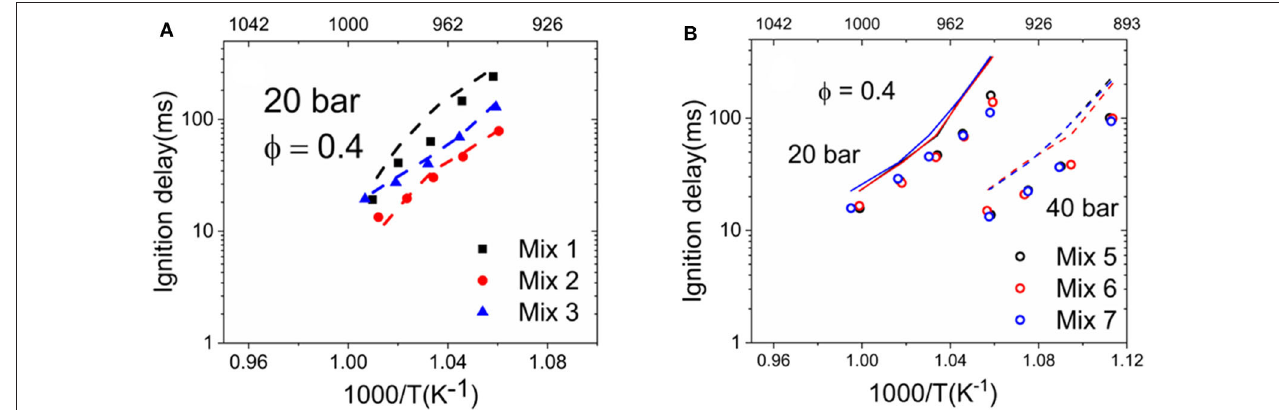
FIGURE 8 | Comparison between the measured ignition delay times (IDTs) of liquefied natural gas (LNG)/liquefied biogas (LBG) mixtures and the simulated IDTs applying the NUIG n -hexane mechanism (Zhang et al., 2015). Symbols are the experimental points, and lines are the simulations. (A) Mix 1-3 (MN 80); (B) Mix 5-7 (MN 74).